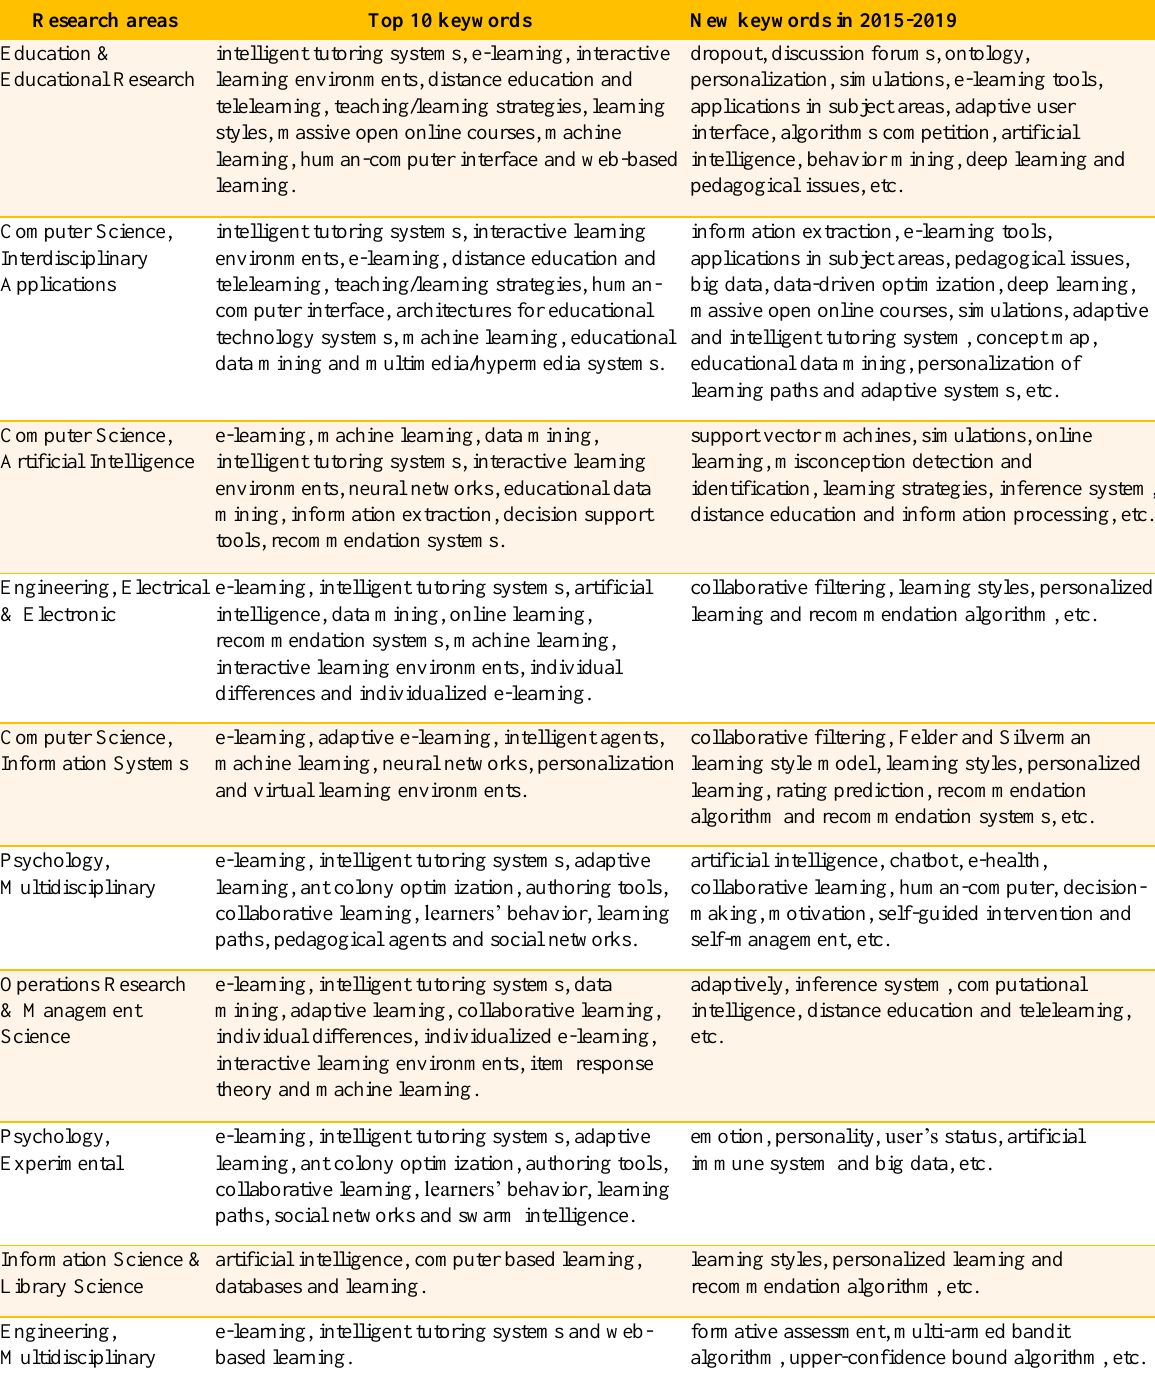
Top Keywords and Newer Keywords Adopted in AIoL